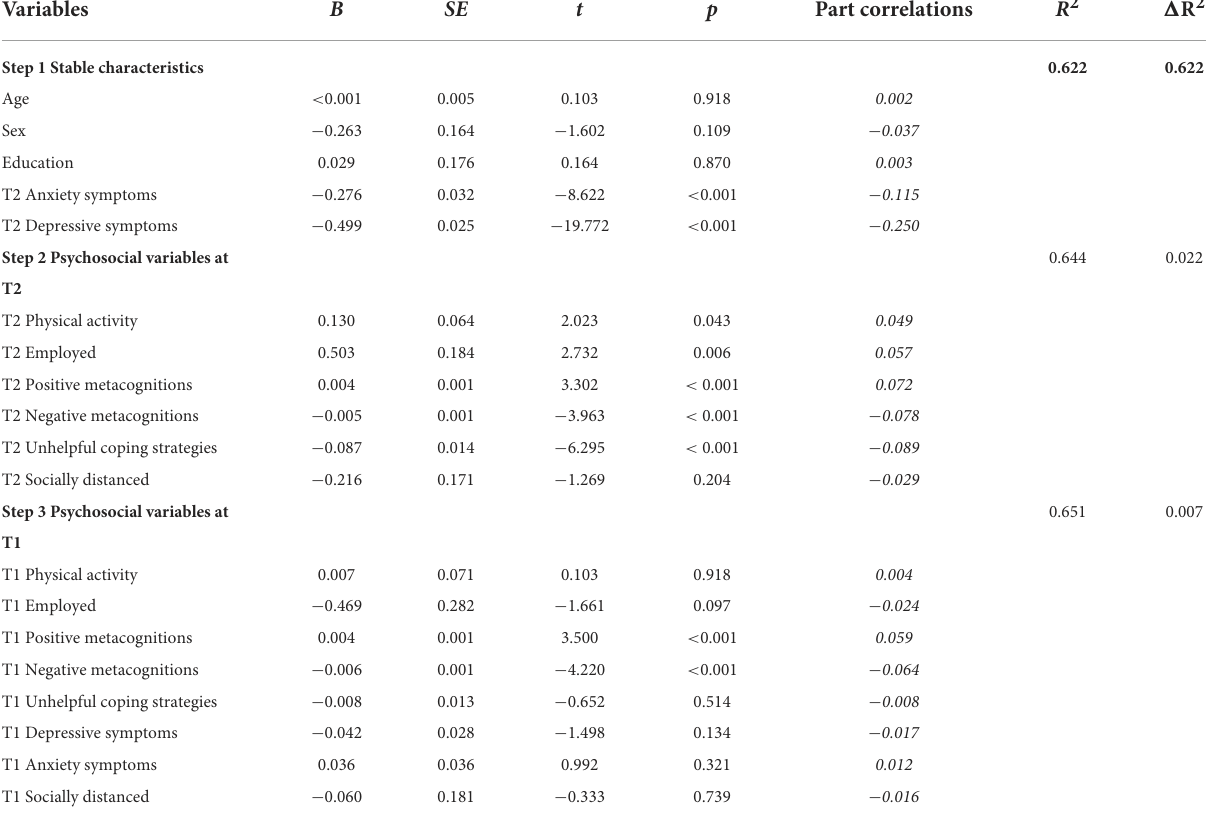
TABLE 3 Results of hierarchical regression with well-being (SWEMWBS) as the dependent variable.